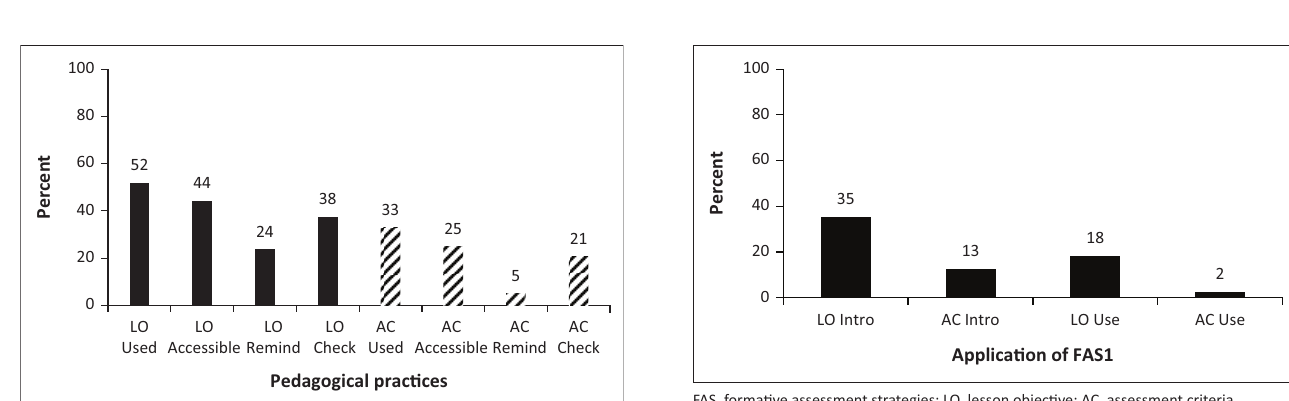
FIGURE 2: Pedagogical practices applied when using lesson objective and assessment criteria during lessons.